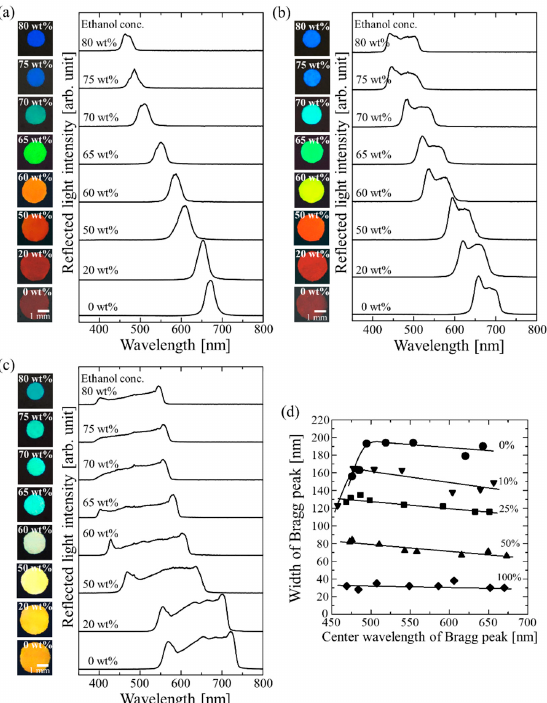
Figure 4. Photographs and reflection spectra of gel-immobilized colloidal crystal films prepared at bottom-light intensities of ( a ) 100%, ( b ) 50%, and ( c ) 0% in ethanol/water solutions with different ethanol concentrations. ( d ) Relationship between the width and center wavelength of Bragg reflection peak of gel-immobilized colloidal crystal films prepared at different bottom-light intensities.